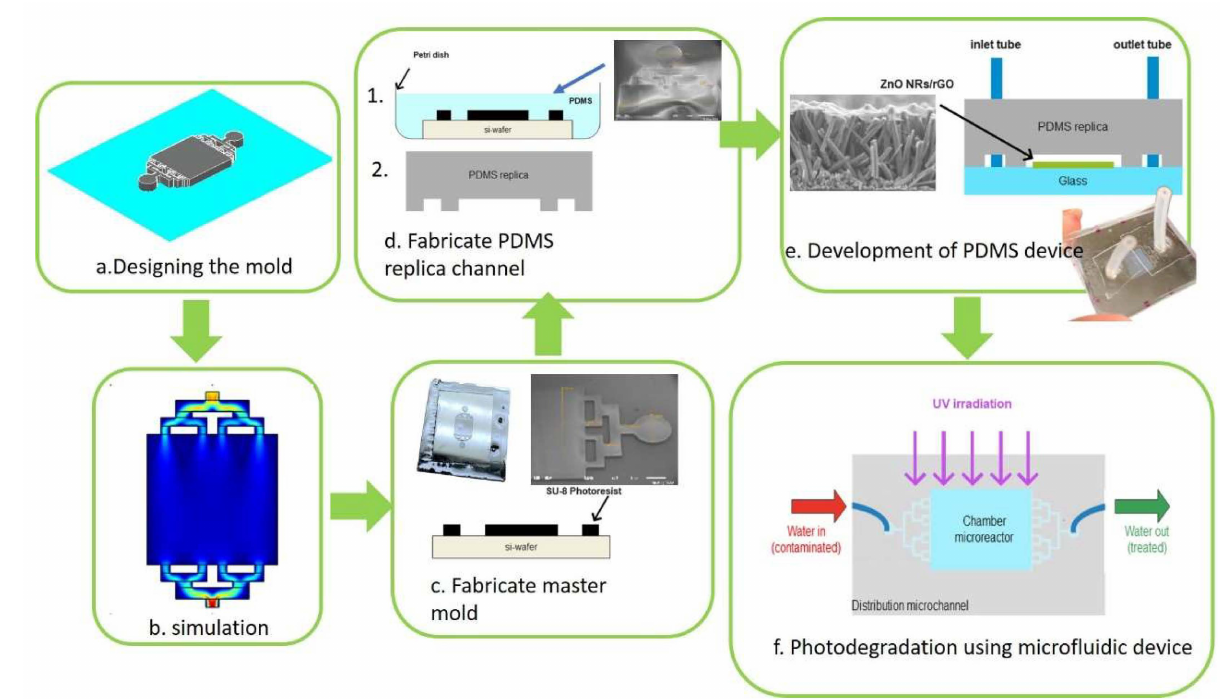
Figure 1. The microfluidic device fabrication steps: ( a ) The 3D mold design. ( b ) Numerical fluid flow simulation. ( c ) Fabrication of master mold (SEM image of SU-8 master mold). ( d ) PDMS casting for microchannel (SEM image of PDMS microchannel). ( e ) The microchannel and PDMS layers are bonded together using plasma bonding to fabricate the microfluidic device (cross-section view of the ZnO NRs/rGO nanocomposite). ( f ) Photodegradation setup, reprinted from Ref.